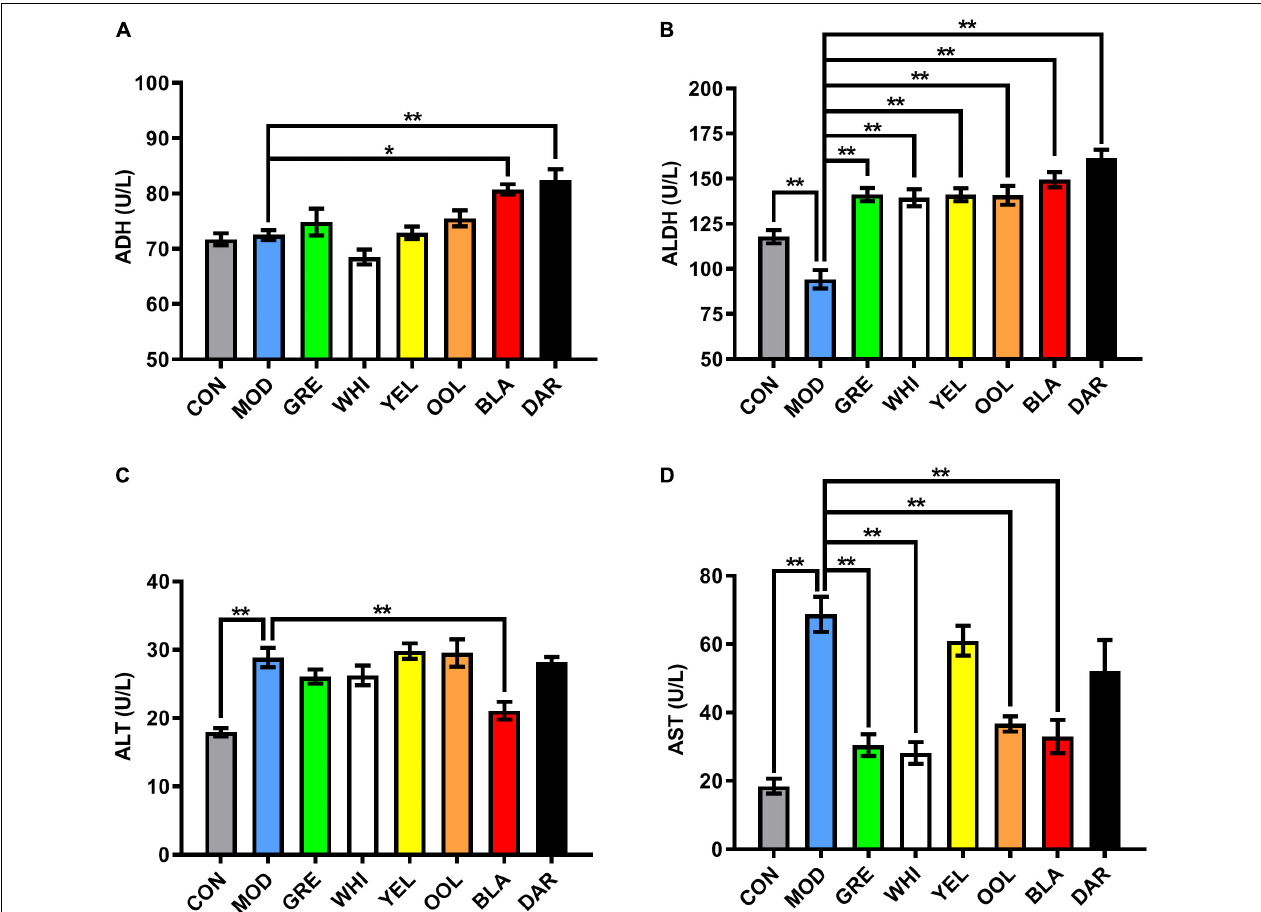
FIGURE 2 | Effect of WEATs treatment on ADH (A) , ALDH (B) , ALT (C) and AST (D) levels in the serum. Each value represents the mean ± SEM ( n = 10). * p < 0.05 vs. MOD; ** p < 0.01 vs. MOD.